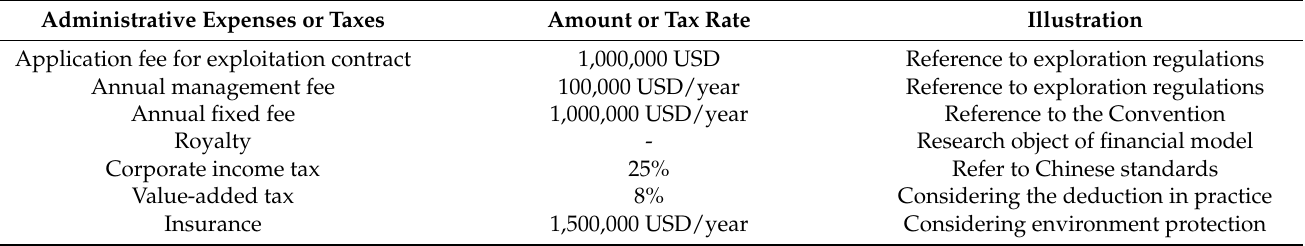
Table 4. Administrative supervision and taxes to be considered in the financial model.